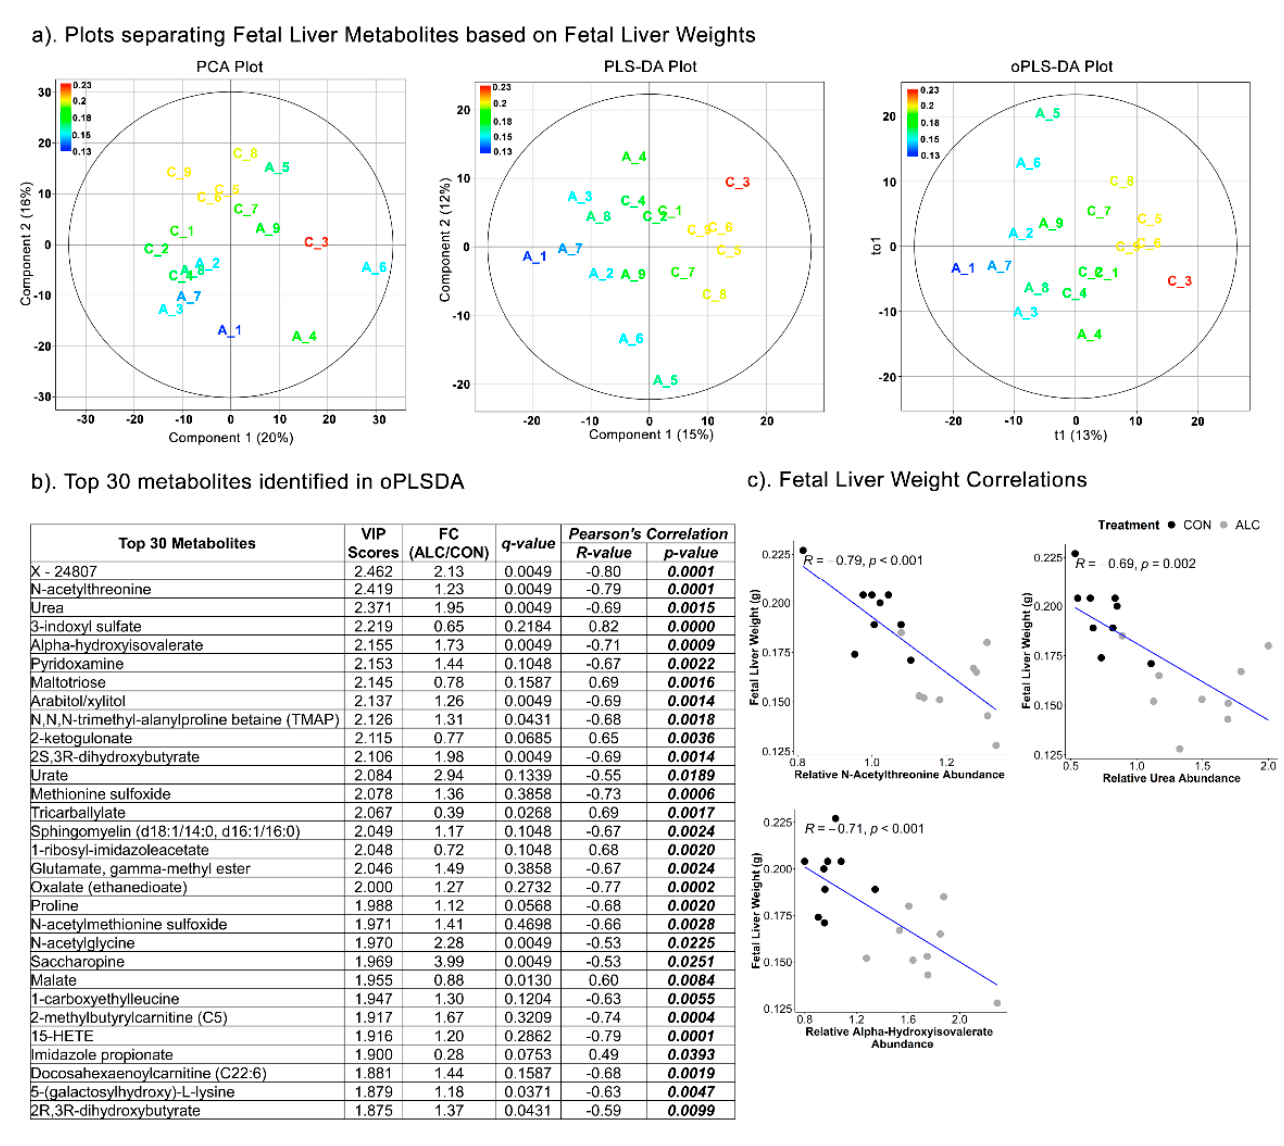
Figure 7. Separation of fetal liver metabolites as ALC vs. CON based on fetal liver weights. ( a ) PCA, PLS-DA, and oPLSDA plots depicting the separation of fetal liver metabolites as ALC vs. CON based on fetal liver weights. The legend and the corresponding color in the plots indicate increase in fetal liver weights (in g) values from blue to red. ( b ) The top 30 metabolites extracted as VIP scores in the first orthogonal component in oPLSDA with FC (ALC/CON), q-value, and Pearson’s correlation (R) analysis with respect to fetal liver weights. Significant correlations at p ≤ 0.05 are bold and italicized. ( c ) Correlation plots of top select metabolites identified in oPLSDA with fetal liver weights. The blue trendlines indicate significant negative correlations.